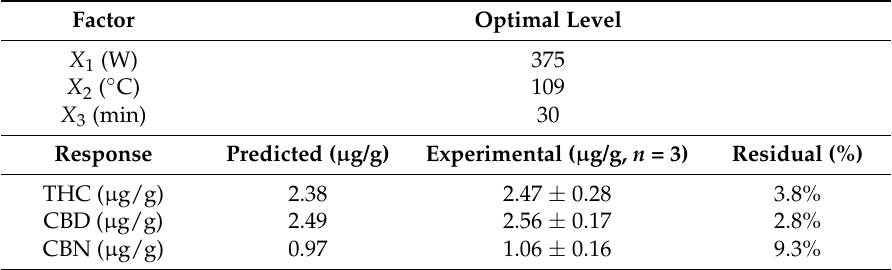
Table 3. Observed and predicted levels for optimal extraction conditions.